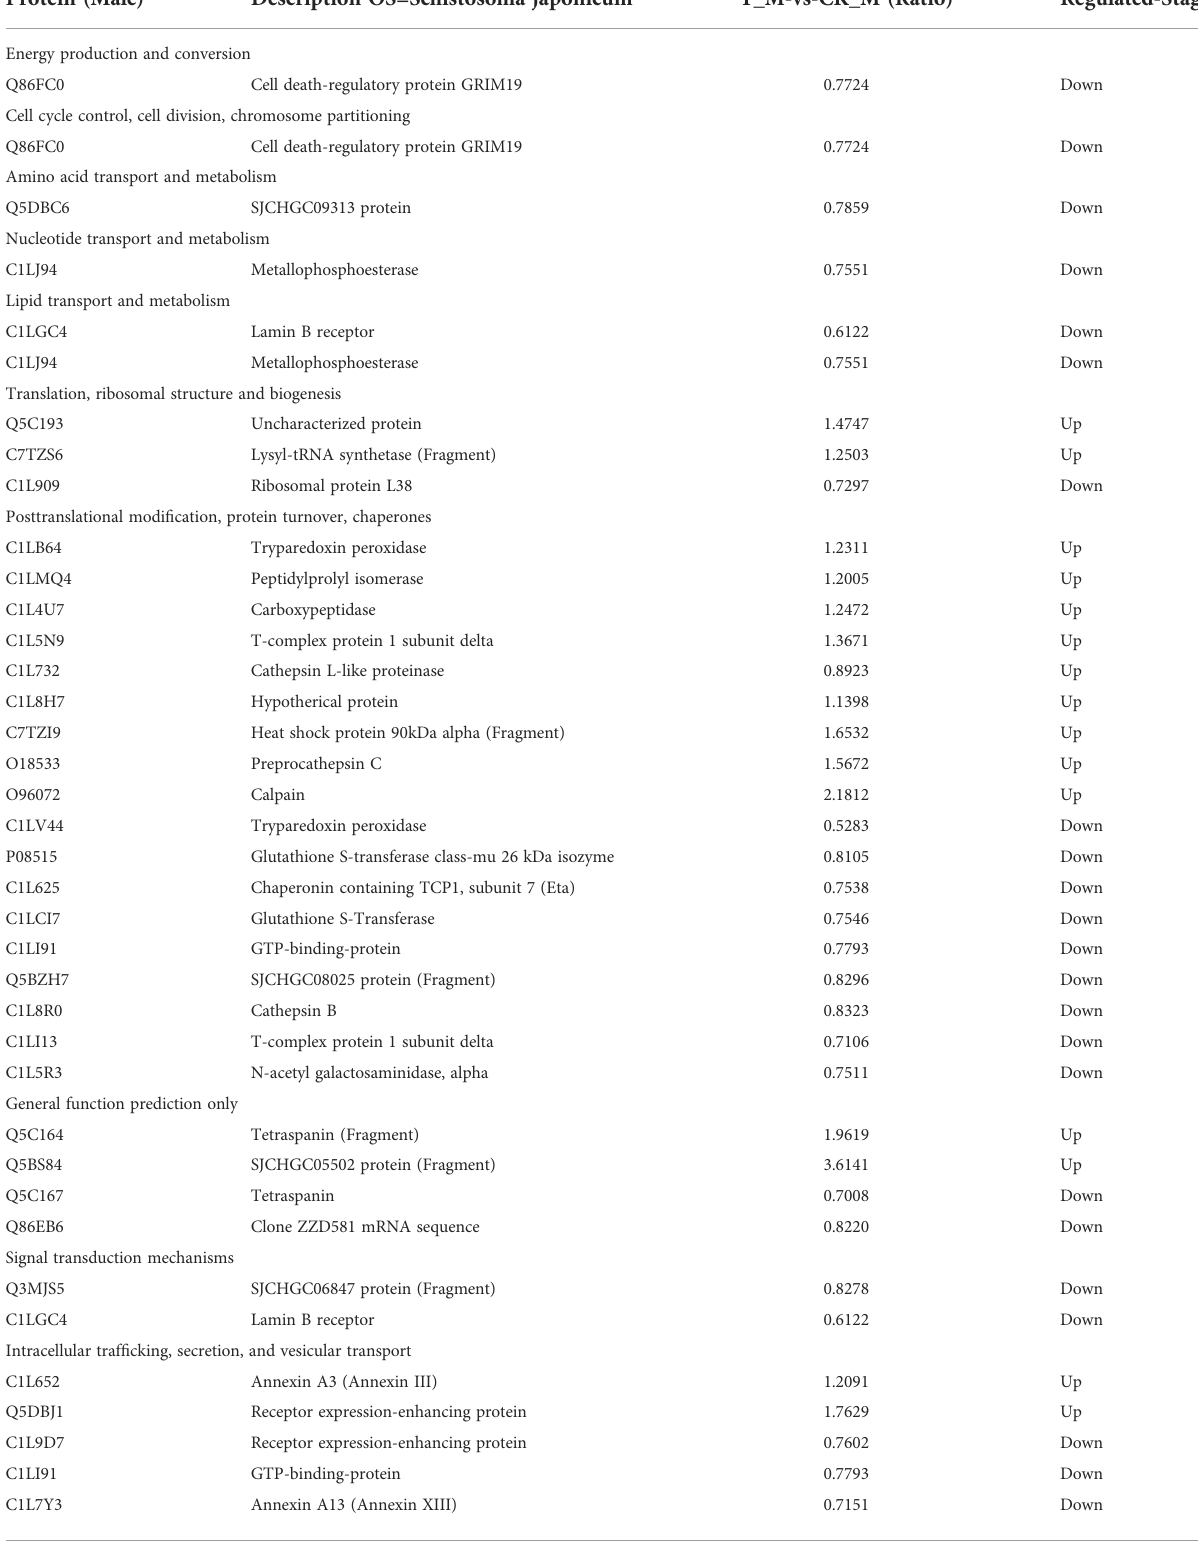
TABLE 2 Putative annotations of differentially expressed proteins (DEPs) of male